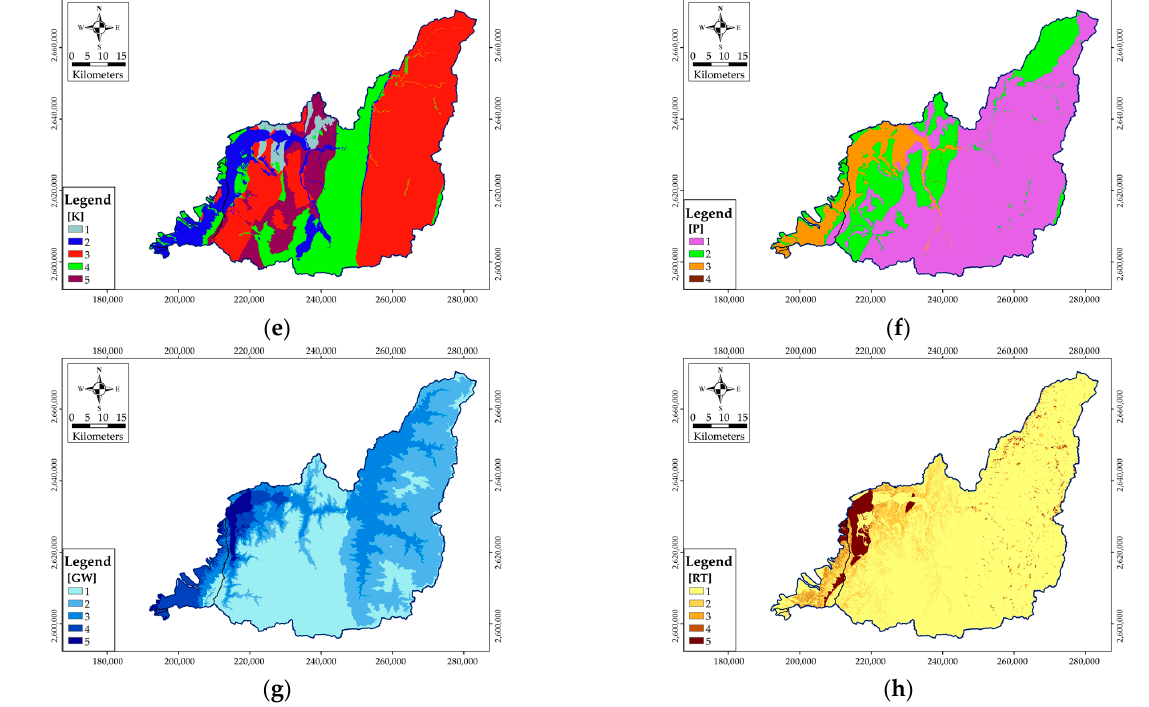
Figure 11. The spatial distributions of the feature score for different influencing factors: ( a ) slope [S], ( b ) drainage density [D], ( c ) land use [LU], ( d ) lithology [LT], ( e ) hydraulic conductivity [K], ( f ) porosity [P], ( g ) depth to the water table [GW], ( h ) regolith thickness [RT].